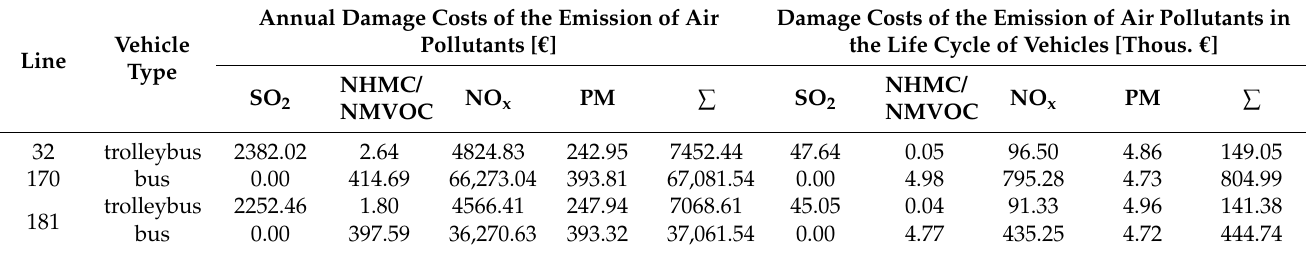
Table 7. Damage costs of the emission of air pollutant from public transport on the analysed